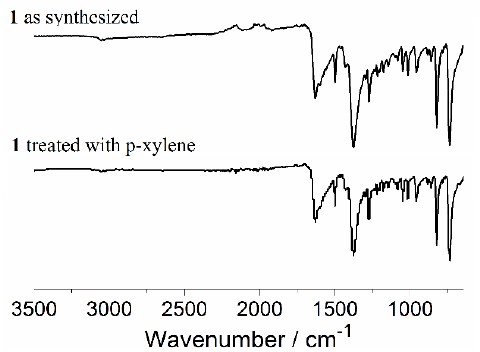
Figure 11. IR-ATR (attenuated total reflection) of as-synthesized 1 and treated with p-xylene isomer.